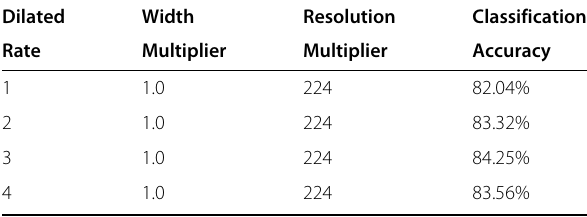
Table 4 Classification accuracy of different dilated rates Dilated